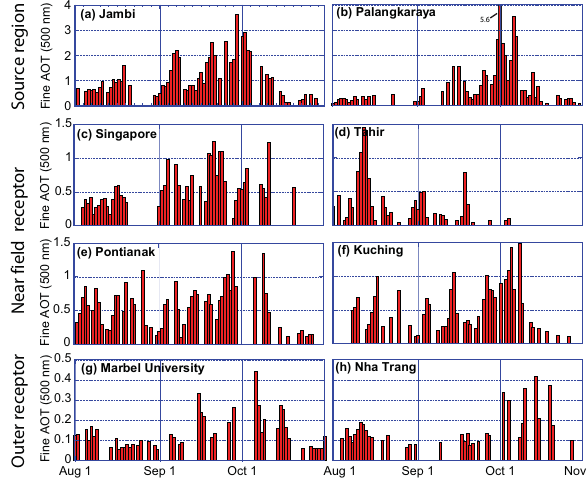
Figure 6. Daily SDA extracted fine-mode AOT from AERONET from August to October 2012. Site locations are labeled with Fig. 1. Zero values indicate data non-availability. For these sites nearly all non-available data are due to cloud